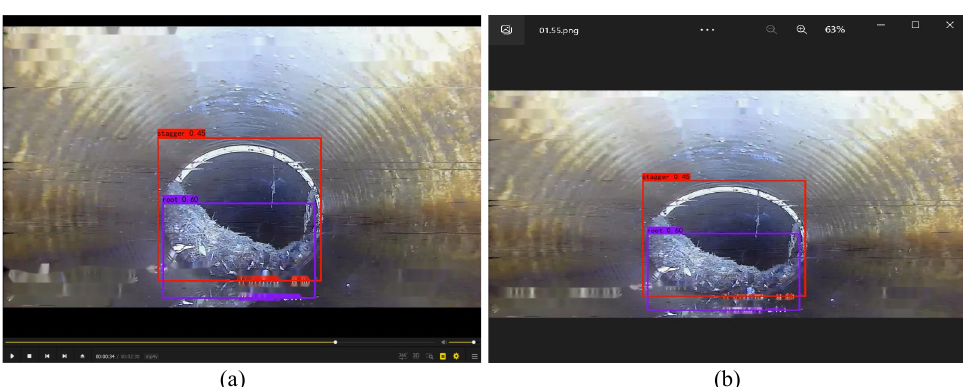
Figure 15. System output results, the red box is stagger, the purple box is root. ( a ) labeled video and ( b ) defect frames. ( b ) defect